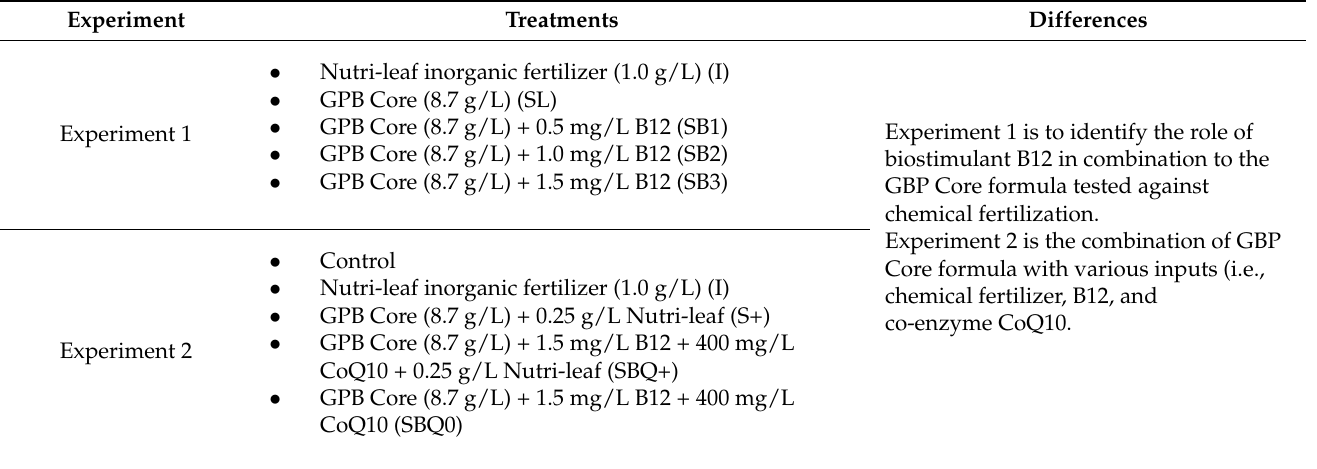
Table 1. Experimental details, treatments plan and their